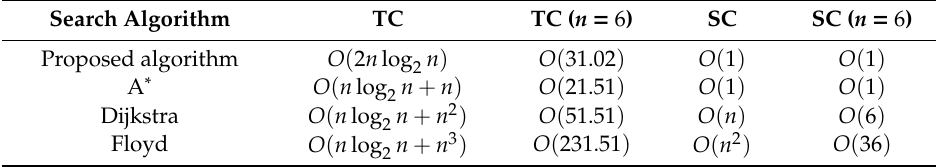
Table 7. Comparison on the time complexity and space complexity of the four